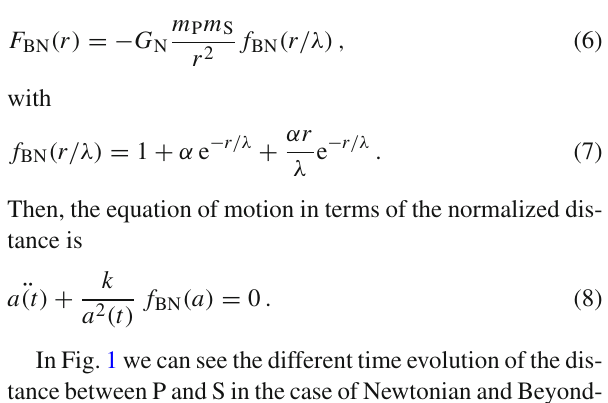
(blue dashed line), α = 1 . 0 (blue dot-dashed line), and α = 5 . 0 (blue dotted line). Right: Relative reduction of the time it takes for S to crash onto P with respect to the Newtonian case, as a function of α . The result is found to be independent of λ if we use the normalized initial conditions stated before (i.e., a 0 = 5 and ˙ a 0 =